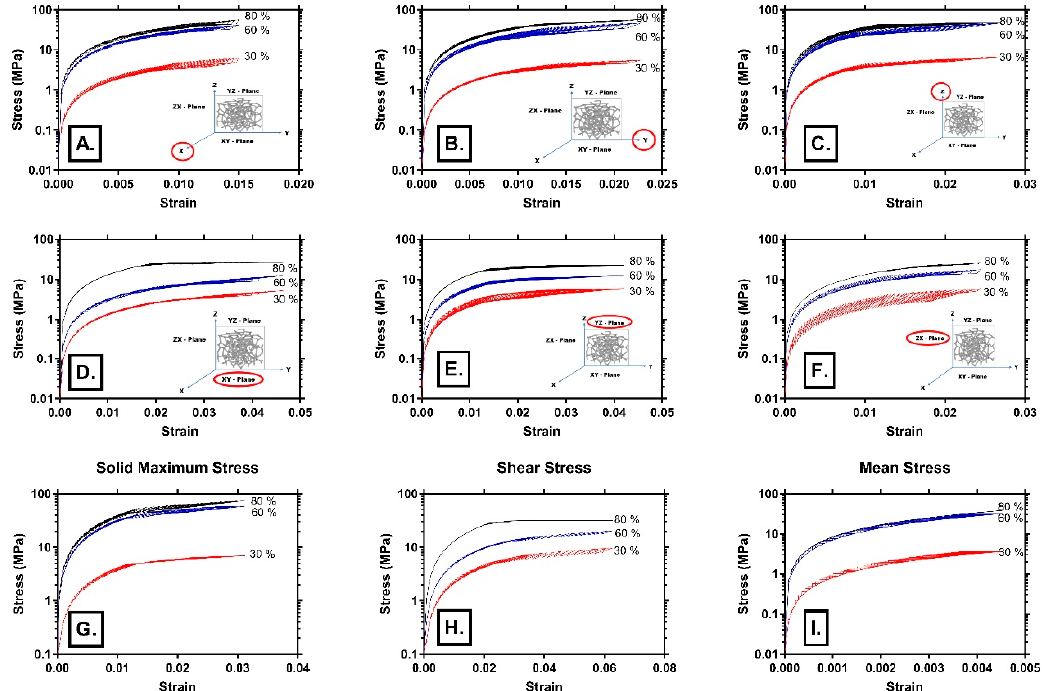
Figure 5. Stress–strain curves for three different porosities (30, 60, 80%): ( A – C ) stresses in x -, y - and z -axis directions as a function of strain, respectively; ( D – F ) shear stresses in xy , yz and zx directions as a function of strain, respectively; ( G – I ) maximum principal stress, maximum shear stress, and maximum mean stress, as a function of strain, respectively.